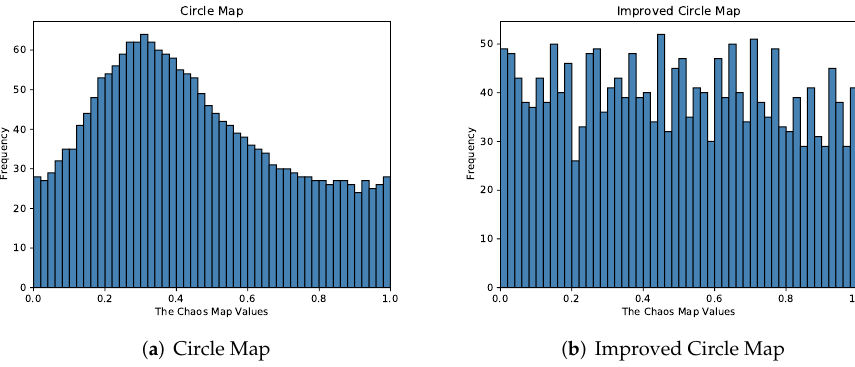
Figure 2. Histogram of Circle Map Frequency distribution before and after